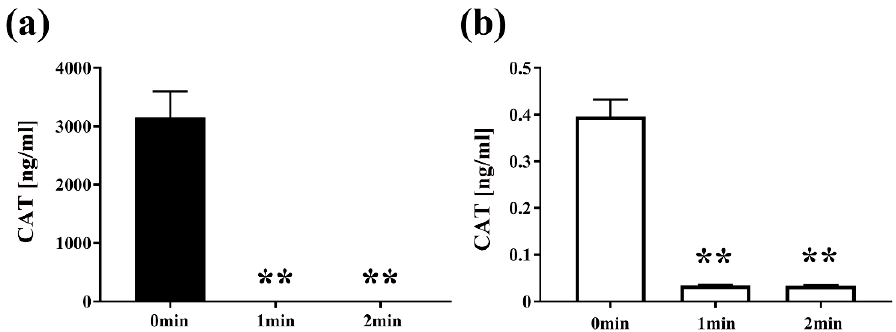
Figure 5. The amount of chloramphenicol acetyltransferase (CAT) in E. coli transformed with a plasmid conferring ampicillin resistance, selected on ampicillin-containing agar medium and then proliferated in liquid medium with ampicillin ( ■ ) or without ampicillin ( □ ), was reduced by DBD plasma torch treatment. E. coli transformed with an ampicillin resistance gene- and CAT gene-containing plasmid pPRO-EX-HT-CAT and selected on ampicillin-containing LB agar were proliferated in ampicillin-containing liquid LB medium (Amp(+)) ( ■ ) ( a ) or ampicillin-free liquid LB medium (Amp( − )) ( □ ) ( b ) and then subjected to DBD plasma torch treatment for 0–2 min. The concentration of CAT (ng/mL) was subsequently measured by enzyme-linked immunosorbent assay (ELISA). Differences where p < 0.01 (**) versus control (0 min) were significant when verified by the non-repeated measured ANOVA followed by the Bonferroni correction.